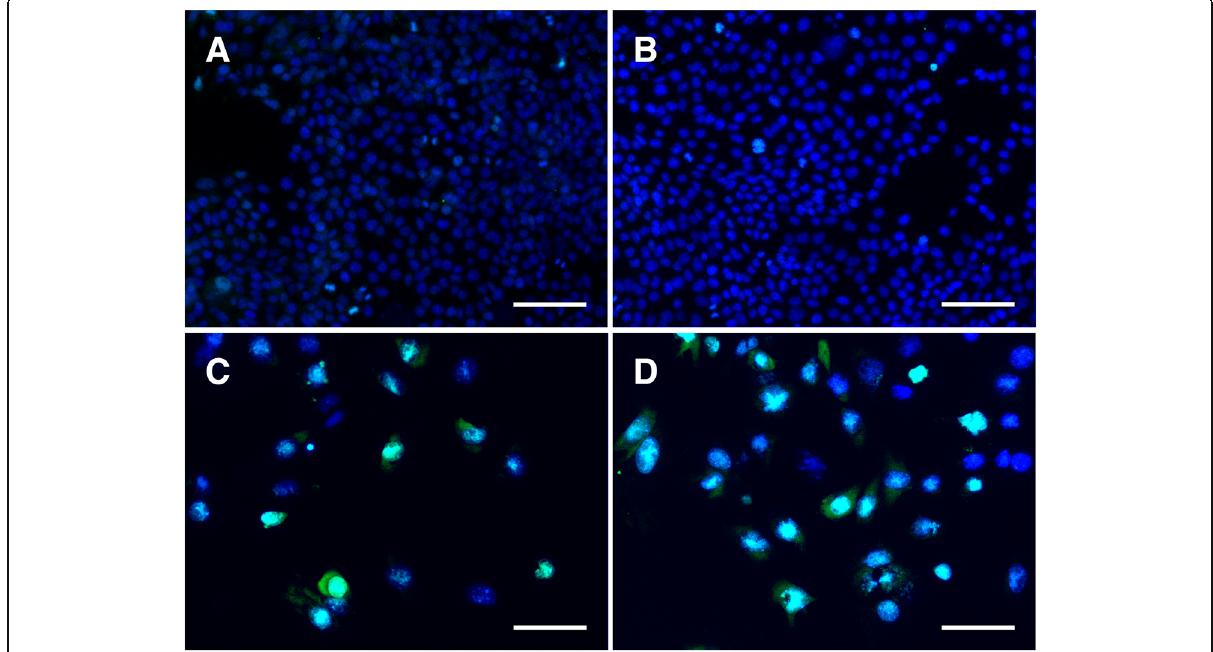
Fig. 5 LIVE/DEAD fluorescence assay demonstrates little to no cell death in untreated 4T1 cells ( a ) and in cells treated with NALG ( b ). Green channel signal intensity (dead cell stain) is strong in a large amount of the cells treated with 0.078 μ g/mL DOX ( c ) and 0.20 μ g/mL NALG-DOX ( d ), indicating cell death. Scale bars indicate 100 μ m. Concentrations indicate amount of DOX, either free or in particle. NALG dosing in ( b ) at same particle density as in